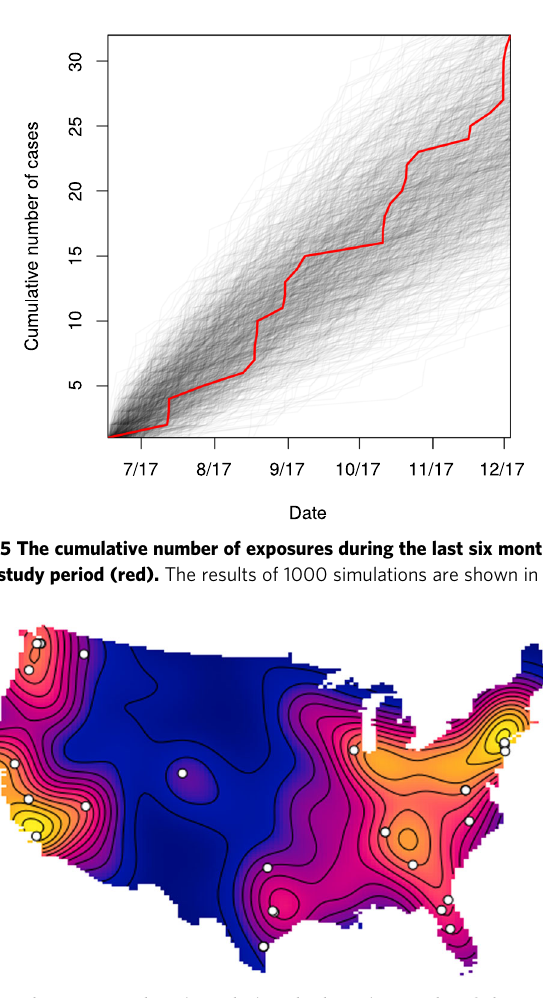
Fig. 6 The exposure locations during the last six months of the study period. The color gradient, ranging from blue (low) to yellow (high), represents a Gaussian kernel density for the results of 1000 simulations with a bandwidth of 200 km. The contour lines segment the kernel density into 10